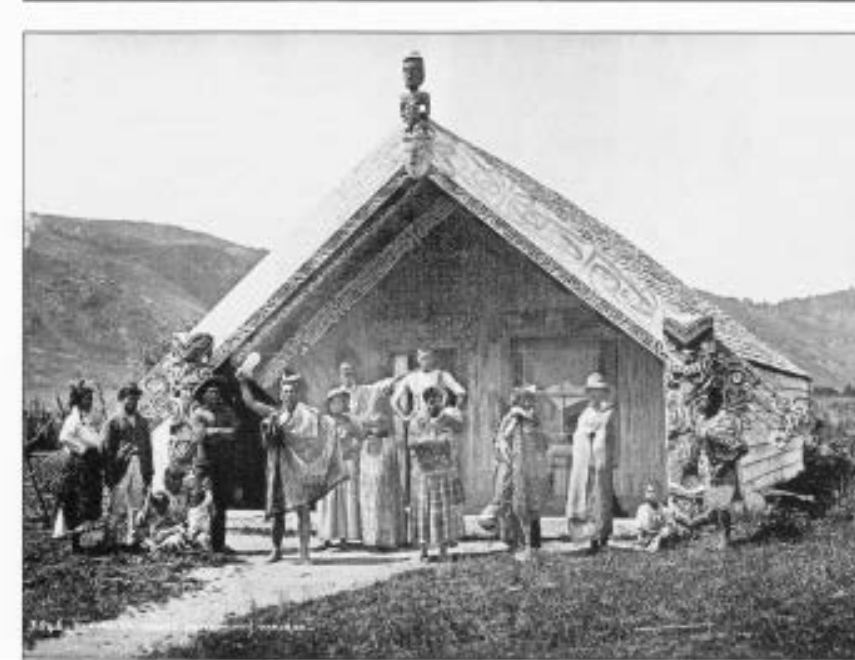
Figure 3 Hinemihi during construction in Te Wairoa, New Zealand, in 1880. Clandon Park, which was being used as a military hospital. Hinemihi is said to